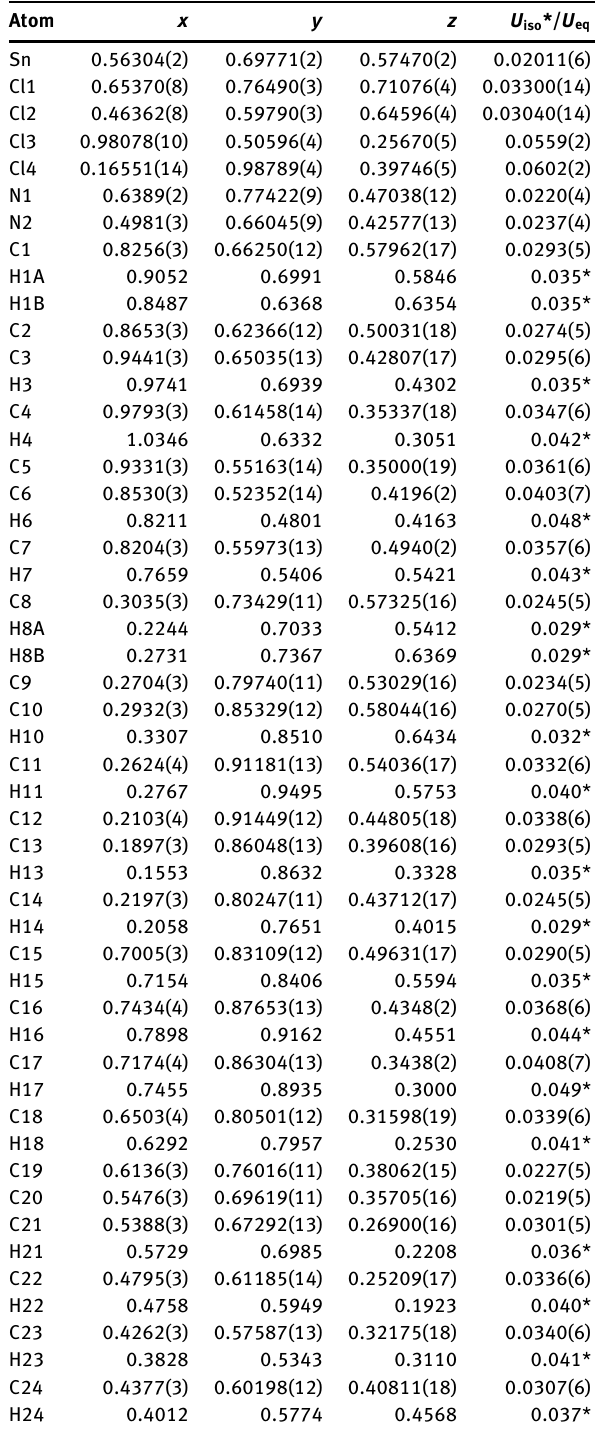
Table 2: Fractional atomic coordinates and isotropic or equivalent isotropic displacement parameters (Å 2